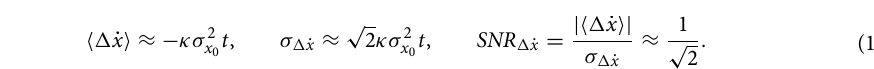
x (middle panel, right column), although ˙ converges to its constant value 0